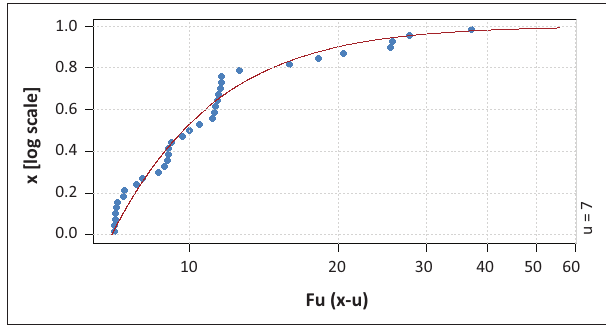
FIGURE 8: South Africa – Diagnostic plot for peak over threshold analysis: Excess distribution.